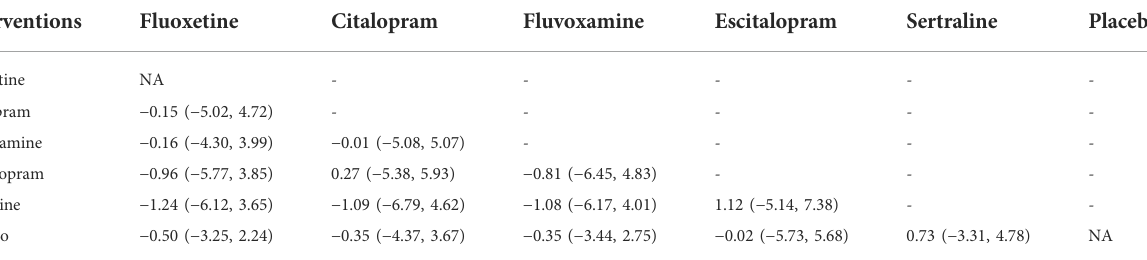
TABLE 3 Network Meta-analysis of dropout